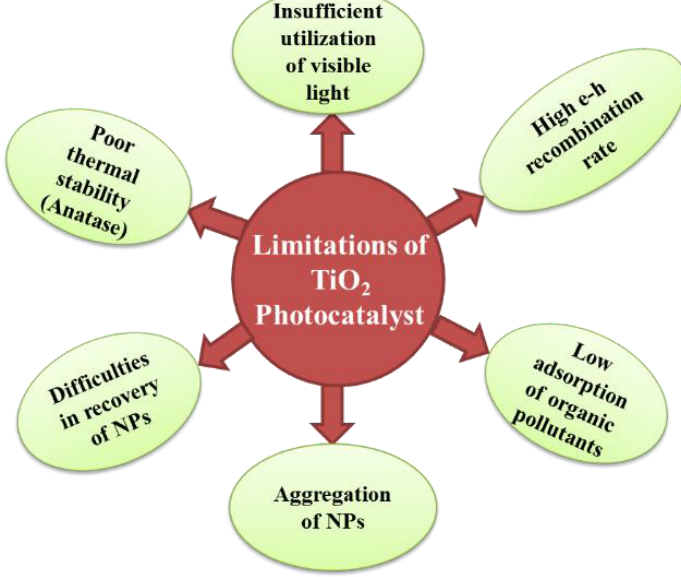
Figure 2. A schematic diagram showing the limitations of TiO 2 photocatalysts.